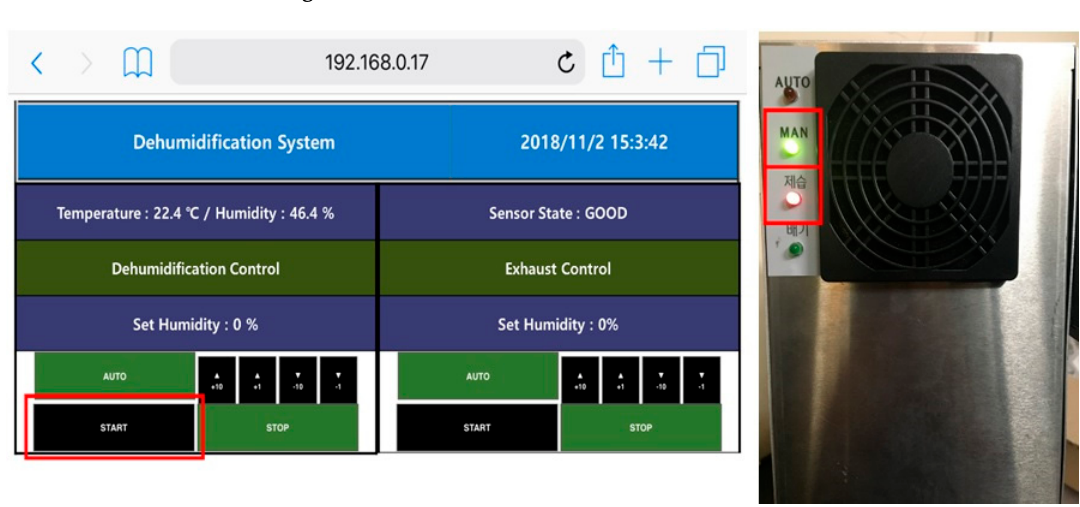
Figure 8. Dehumidification control—“AUTO” mode.